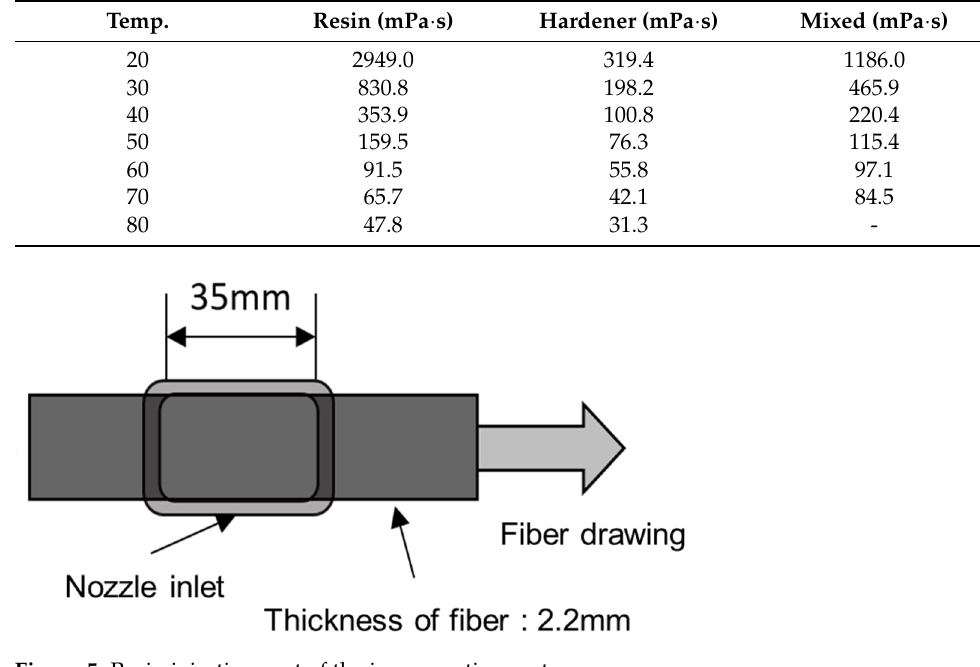
Table 2. Viscosity of the resin required for full impregnation with different pultrusion speeds. Pultrusion